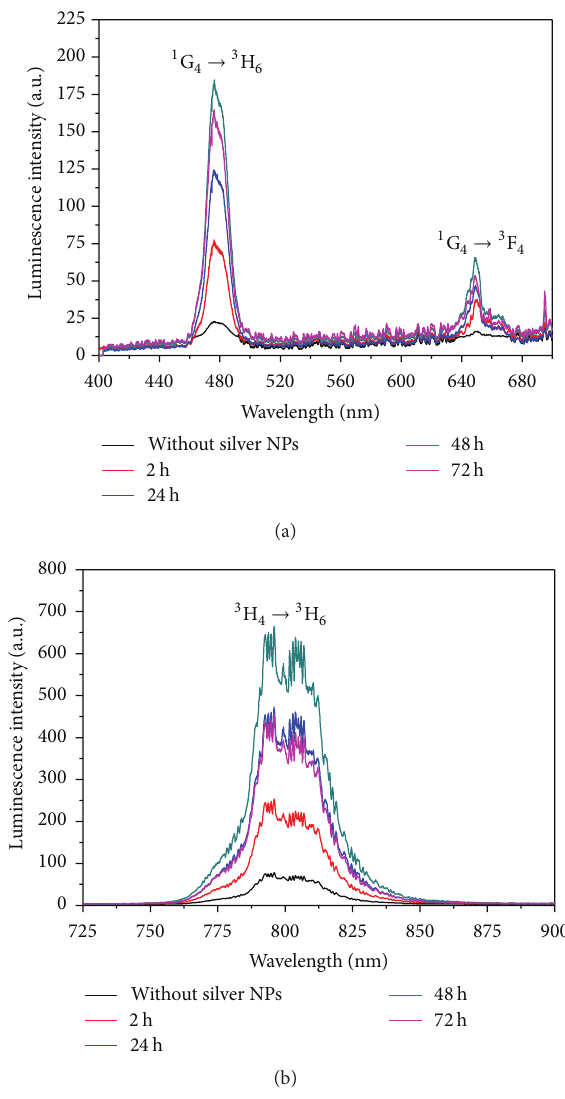
Figure 10: Emission spectra of TZO-Tm:Ag glasses for different heat-treatment times